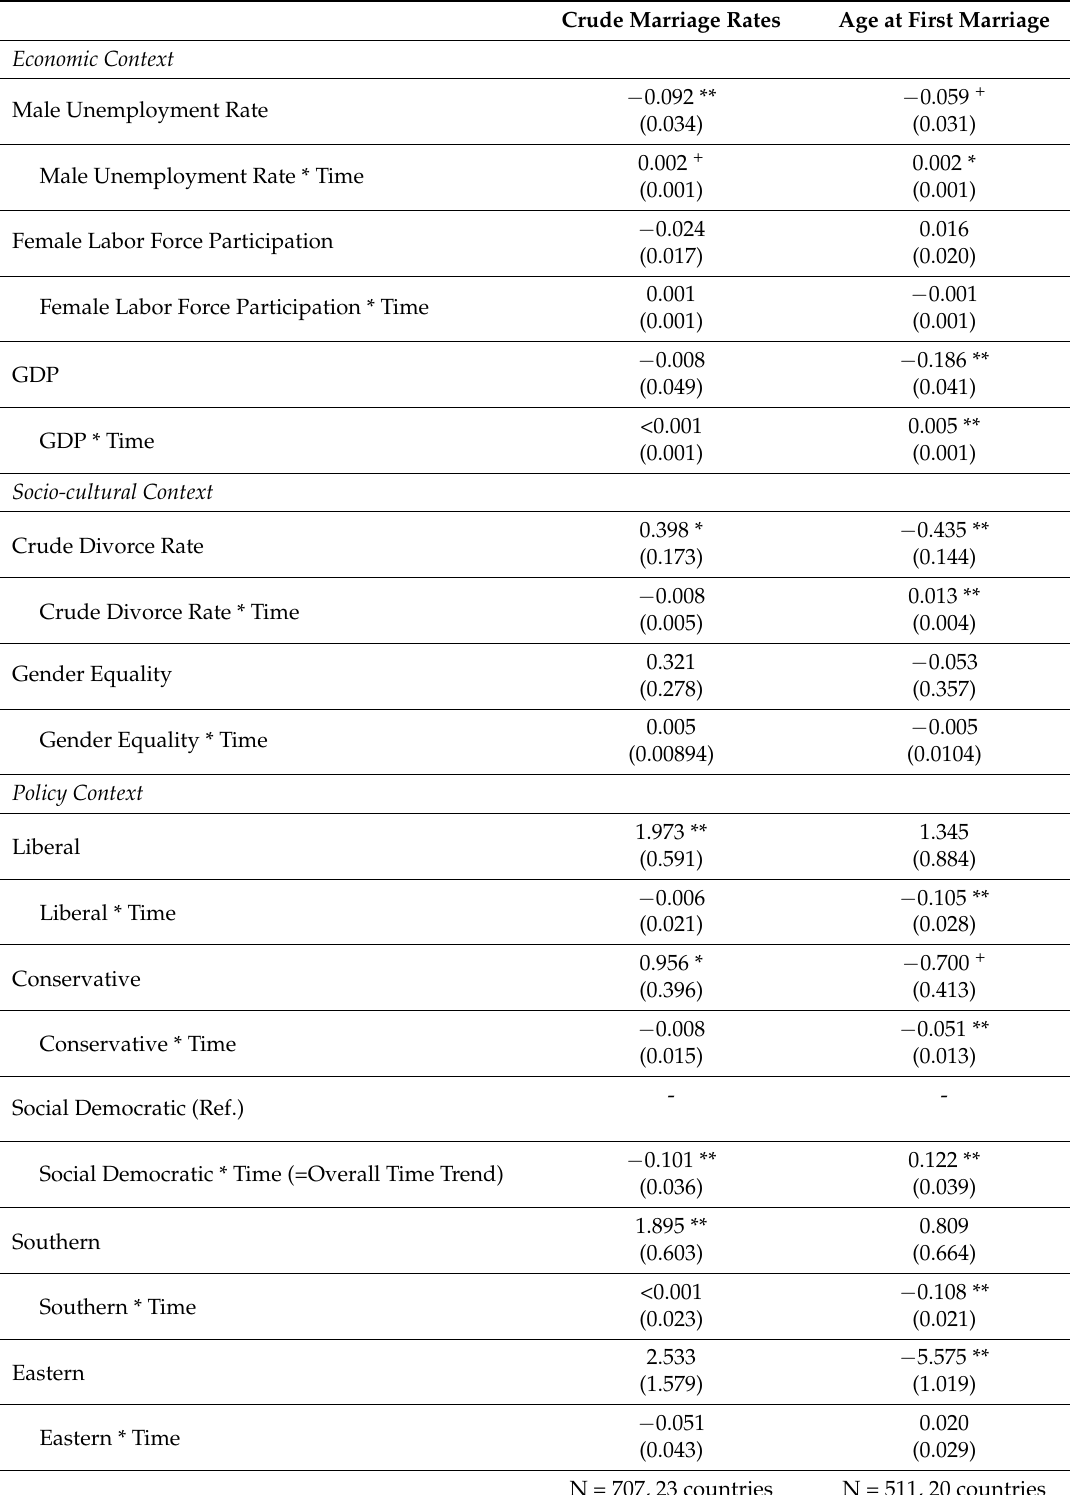
Table 4. Panel Corrected Prais-Winsten Models for Marriage Rates and Age at First Marriage with Trends over